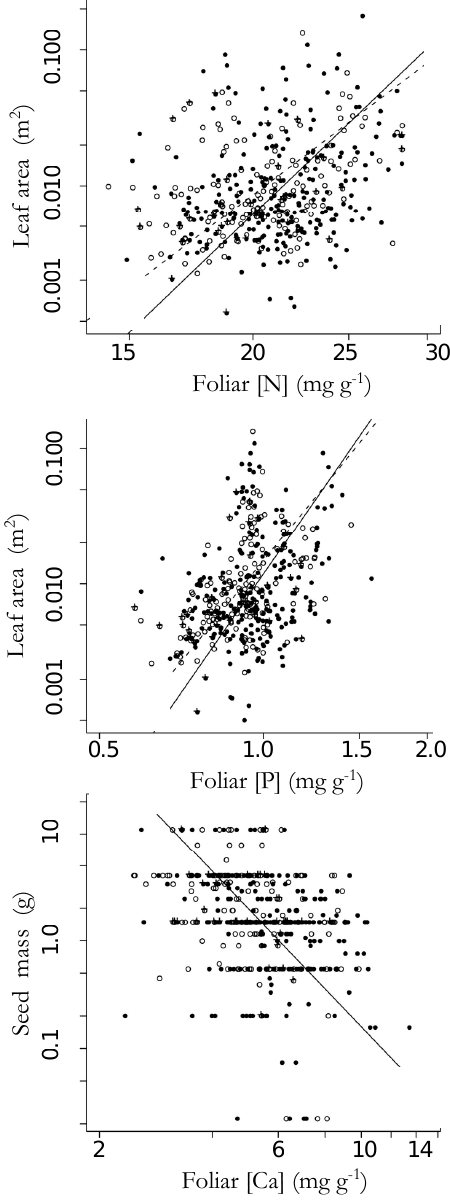
Fig. 6. Standard Major Axis (SMA) regression lines between de- rived taxonomic components of foliar [N] and foliar [P] and leaf mass per unit area ( L A ) for the top two panels and between species estimated foliar [Ca] associated average seed mass ( S ) for the as- sociated genus (bottom panel). Open circles indicate species found on low fertility sites and the closed circles indicate species found on high fertility sites. Species found on both soil fertility groups are designated by a “+” (see text for details). For the top two pan- els, solid lines show the SMA fit for low fertility soil species which are significantly different to the dashed lines for high fertility soil species. For the bottom panel the solid lines shows the SMA model fit which did not depend on soil fertility.